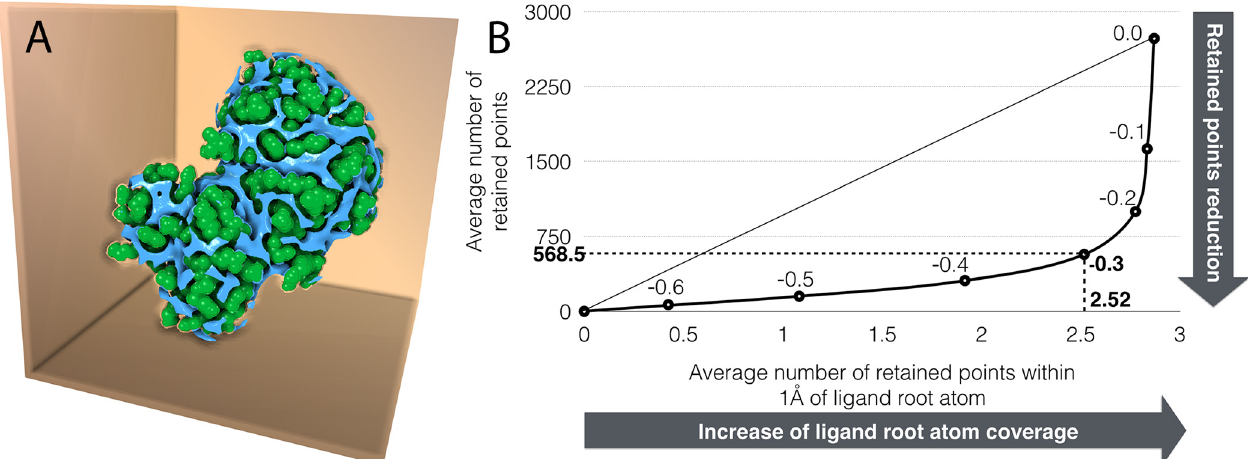
Fig 4. A) Translational points. The surface enclosing points of the carbon affinity map located outside the protein and with carbon affinity less than or equal to -0.3 kcal/mol is shown in blue; protein atomic spheres (with reduced vdW radii) are shown in green. The set of translational points cover grooves and cavities that can accommodate a ligand and provide sensible initial placement points for the ligand root atom. B) Translational points cutoff value selection For energy cutoff values varying from 0.0 to -0.6 kcal/mol in decrements of 0.1 kcal/mol, the average number of grid points retained is plotted against the average number of retained grid points within 1 Å of the ligand root atom. The average is computed over the 85 systems in the Astex Diverse set. Lower energy cutoff values produce fewer translational points, however they increase the chance of discarding points surrounding the ligand root atom (i.e. reducing coverage of the root). The value of -0.3 kcal/mol is the closest to the curve ’ s inflection point and was selected as the best cutoff value to maximize the reduction in retained points and maximize the coverage of the ligand root